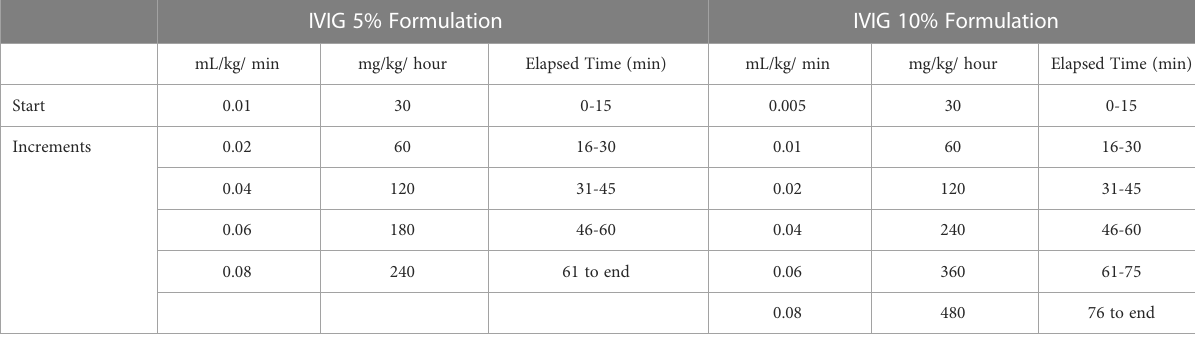
TABLE 2 Infusion rate protocols